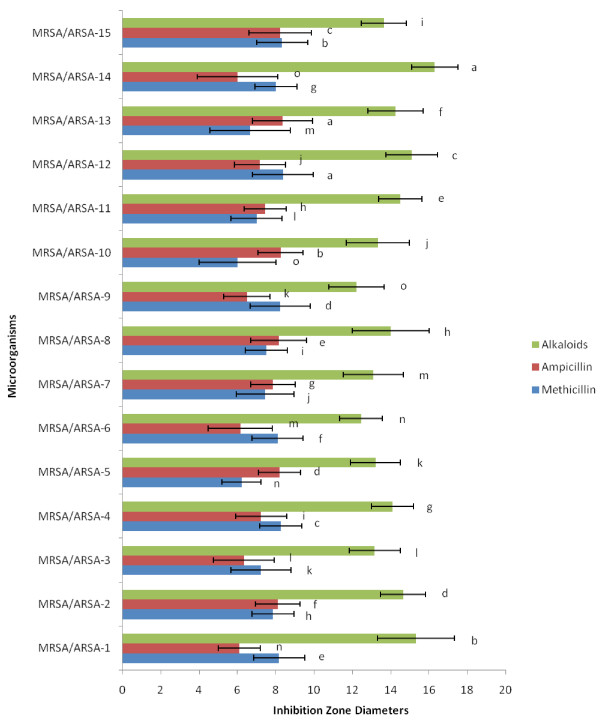
 Inhibition Zone Diameters of Alkaloid compounds fromCienfuegosia digitataCav. and conventional antibiotics (Methicillin and Ampicillin). The results are the means of number of the colonies ± standard deviations.